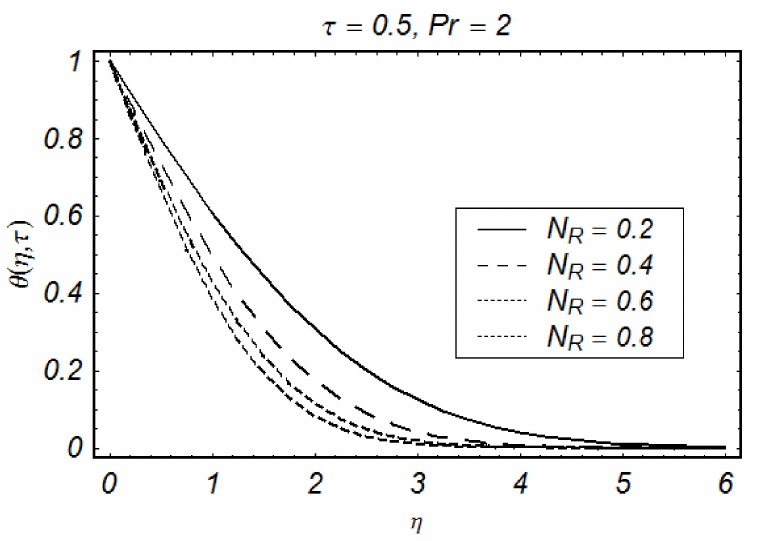
Figure 12. Indication of N R on temperature